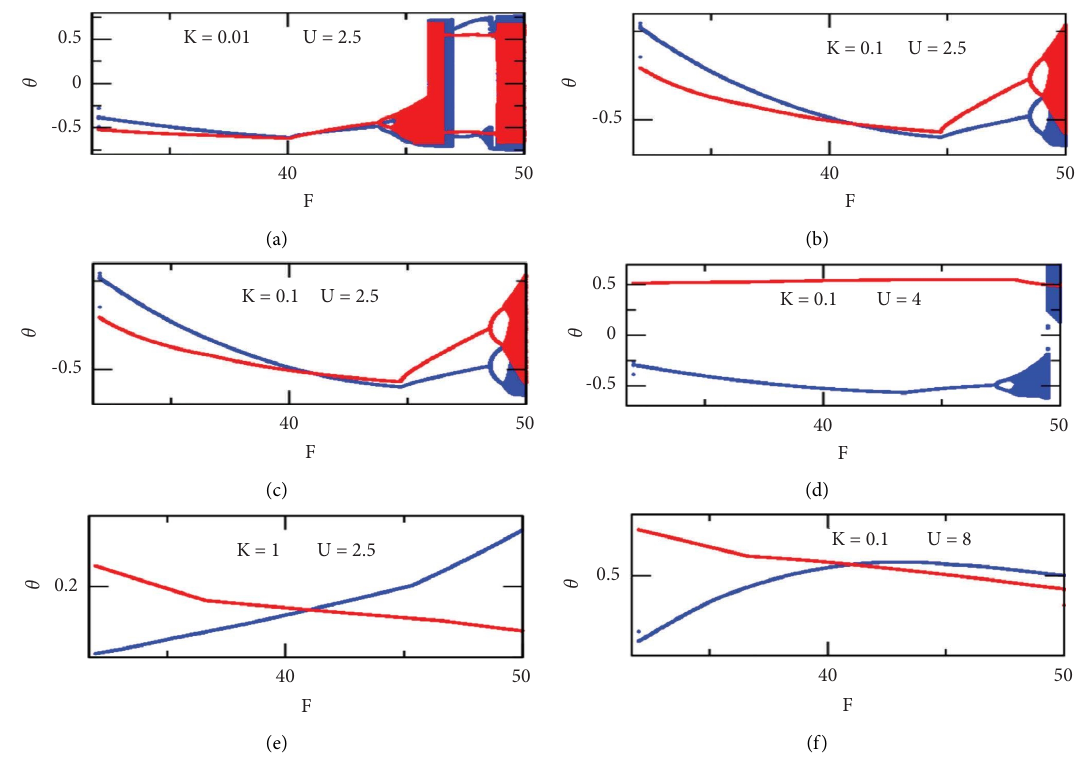
Figure 13: Effect of the parameters K and U on the bifurcation diagram for ϵ � − 1 ; α � 10 ; β � 1 ; Ω � 2 ; C 10. )e diagrams are drawn by sweeping the normalized amplitude F in the ascending direction (blue) and in the opposite direction (red).